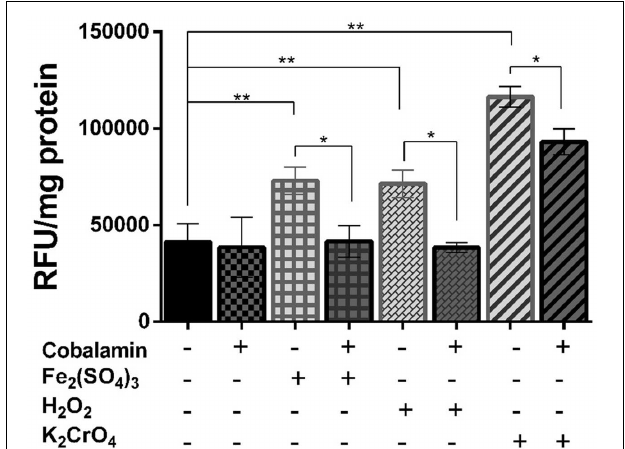
FIGURE 1 | Effect of cobalamin on ROS generation. Cytoplasmic ROS content was estimated by measuring activation of the fluorescent-probe H 2 DCFDA in Leptospirillum CF-1 cells treated with oxidative agents as indicated under Section “Materials and Methods.” Fluorescence values were expressed as relative fluorescence units (RFU). Bars represent the average of three independent experiments ± standard deviations. ∗ P < 0.05, ∗∗ P <